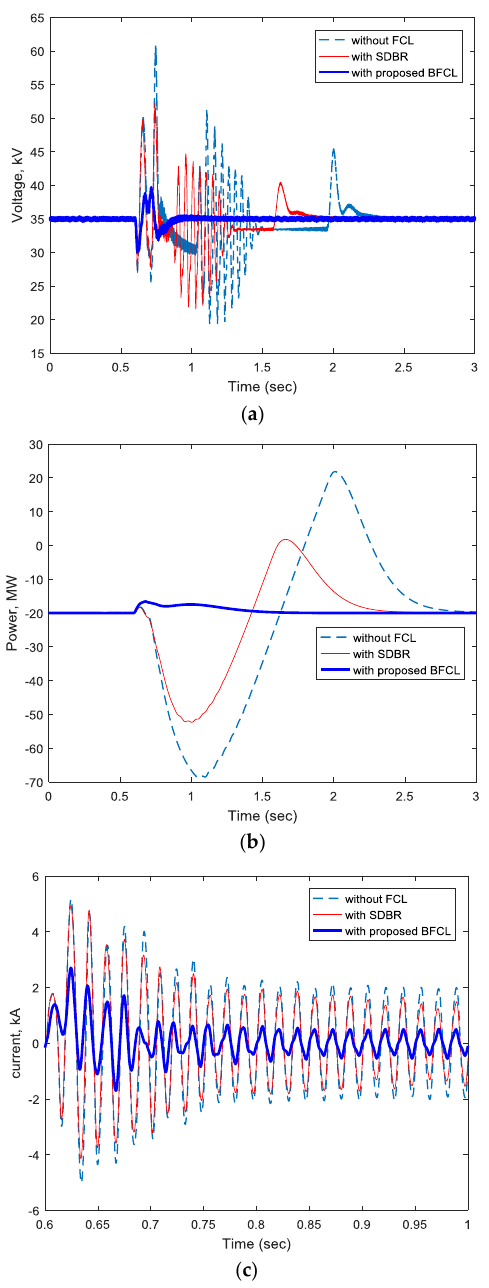
Figure 5. Comparative transient response of two grids connected VSC-HVDC system subject to symmetrical fault at grid1 ( a ) DC link voltage ( b ) Grid1 active power flow ( c ) Phase ‘a’ current of grid1. Detailed voltage and current stresses across of shunt branch and IGBT switch of BFCL during three phase symmetrical fault are clearly visualized in Figure 6a–d.